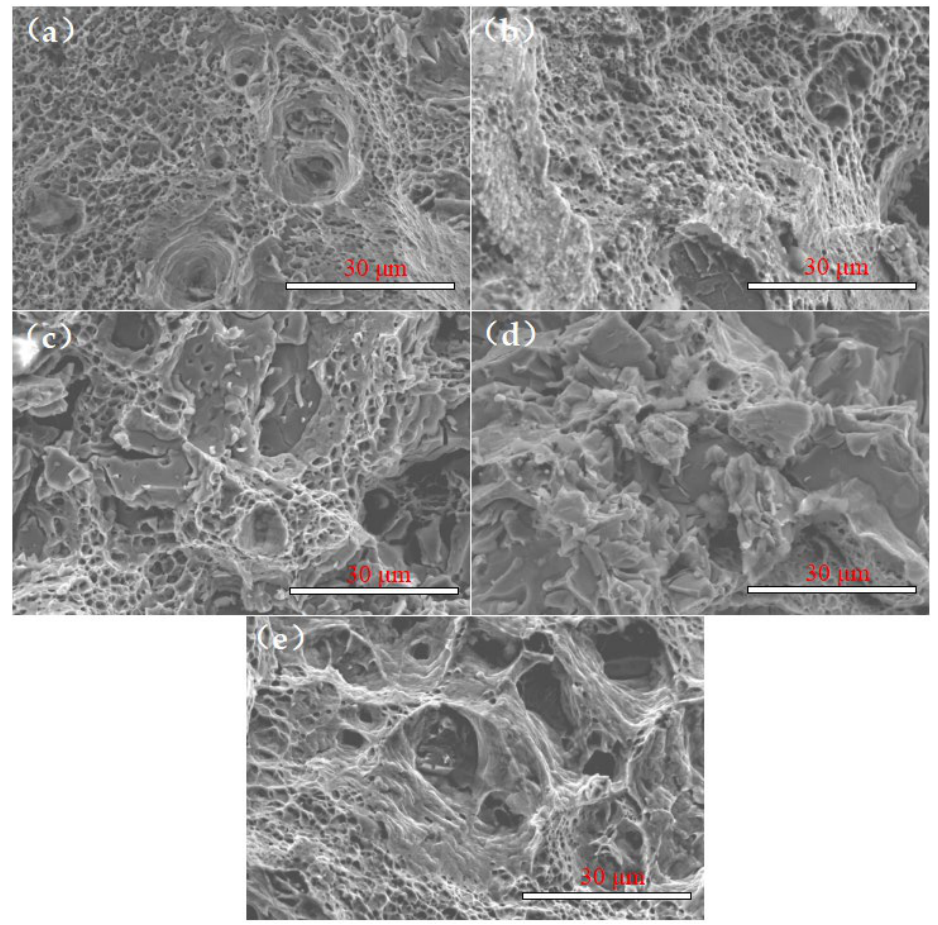
Figure 7. Tensile fracture morphology of as-cast and heat-treated FeCrMnNi alloys ( a ) as-cast, ( b ) 700 °C, ( c ) 800 °C, ( d ) 900 °C, ( e ) 1000 °C.